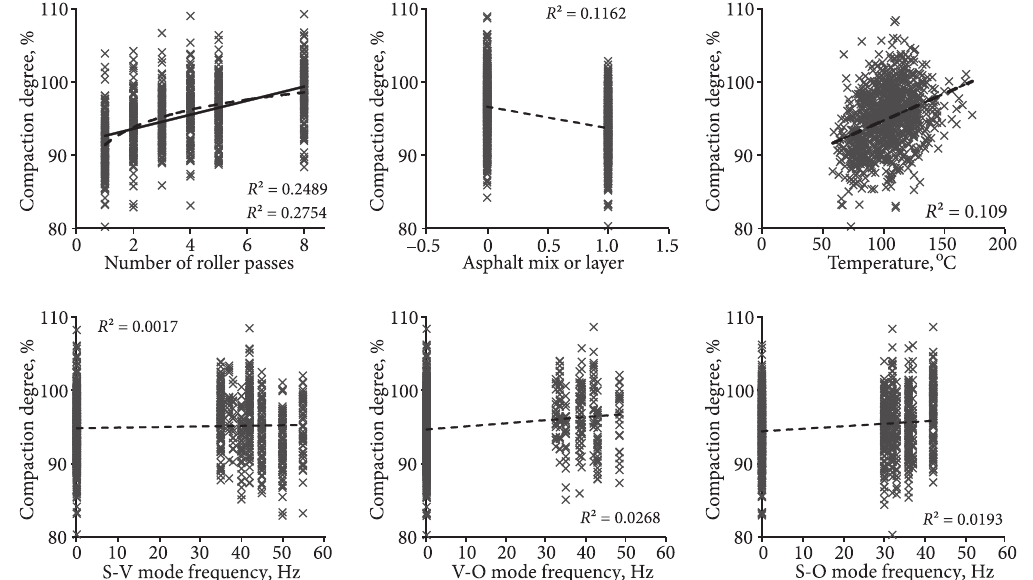
fig. 7. Scattering diagrams of CD with all test variables ( NDG data): roller passes; layer; temperature; V frequency; V-O frequency; O